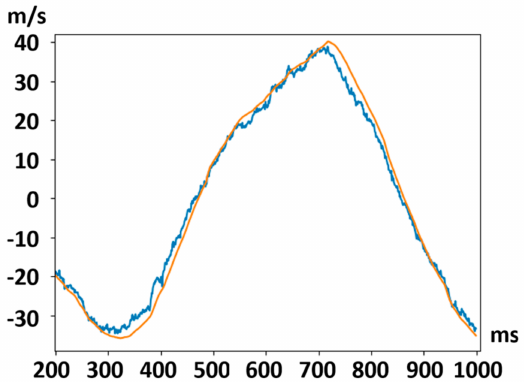
Figure 15. Output response of 2 layers EKF with actually swaying within ± 40 degrees.